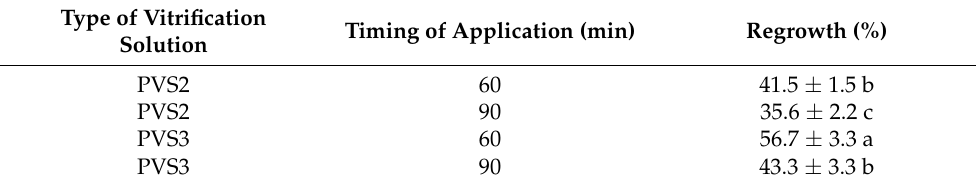
Table 1. Effect of the type of vitrification solution (PVS2 or PVS3) and duration (60 or 90 min) on